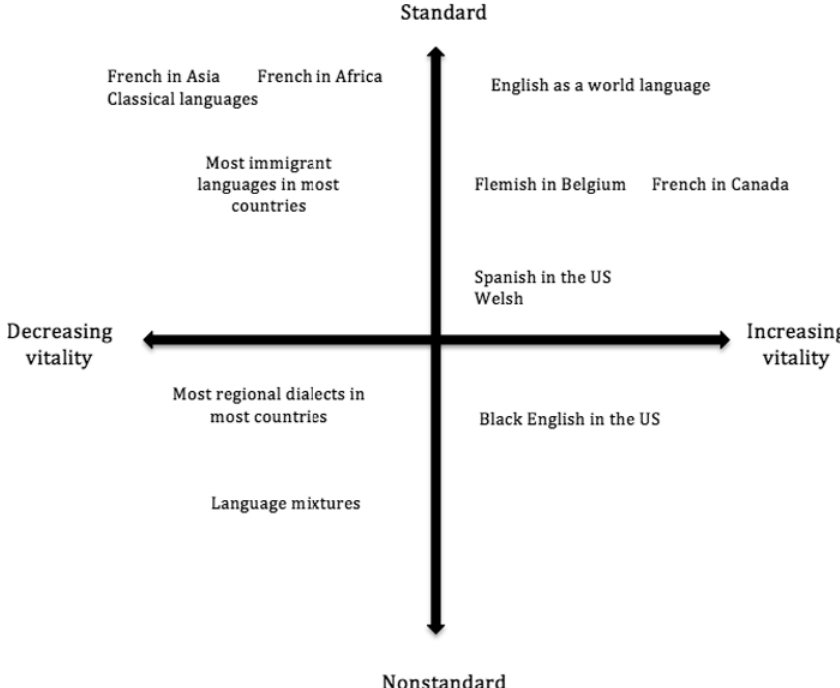
Figure 2 Standardisation and Vitality